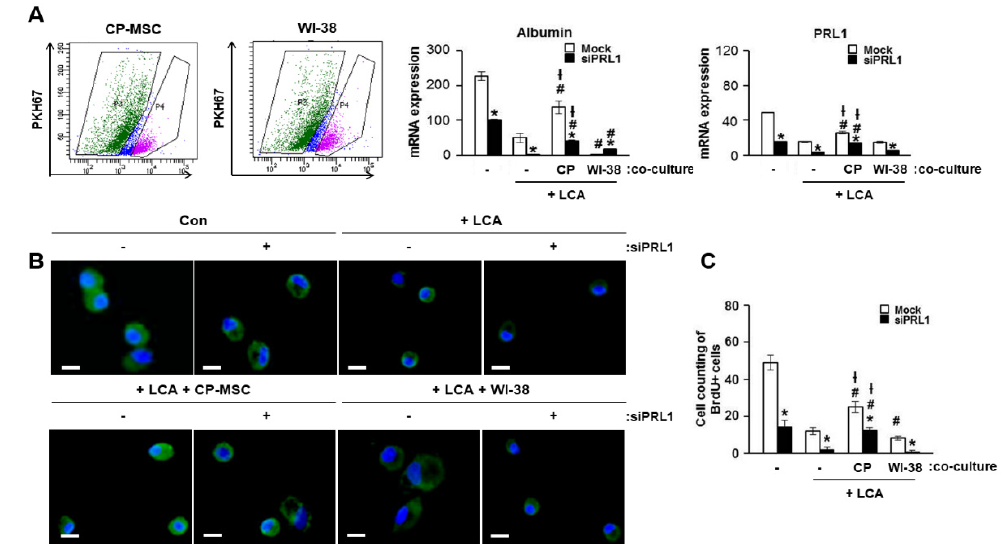
Figure 6. Increased PRL ‐ 1 expression by CP ‐ MSCs correlates with hepatocyte proliferation. ( A ) The fraction of PKH67 ‐ negative primary rat hepatocytes was sorted by flow cytometry in the CP ‐ MSC and WI ‐ 38 direct co ‐ cultured group 24 h after treatment with siRNA ‐ PRL ‐ 1. mRNA expression of albumin and PRL ‐ 1 in sorted primary rat hepatocytes treated with siRNA ‐ PRL ‐ 1 after direct co ‐ culture with CP ‐ MSCs and WI ‐ 38 was examined by qRT ‐ PCR. The localization of ( B ) albumin and ( C ) BrdU ‐ positive hepatocytes was determined with immunofluorescence in rat primary hepatocytes isolated from a BDL rat model treated or untreated with siRNA ‐ PRL ‐ 1 after culturing with or without CP ‐ MSCs or WI ‐ 38 cells. Rat primary hepatocytes expressed green fl uorescent protein and were stained for ALB (green) with 4 ʹ ,6 ‐ diamidino ‐ 2 ‐ phenyl ‐ inodole (DAPI) (blue). A representative overlay image is shown. The scale bar represents 50 μ m. The data are expressed as the mean ± SEM (* p < 0.05 compared with siRNA ‐ PRL ‐ 1treatment group; # p < 0.05 compared with the LCA treatment group; † p < 0.05 compared with the treatment regardless of LCA or siRNA ‐ PRL ‐ 1). CP, CP ‐ MSCs; siPRL1, siRNA ‐ PRL ‐ 1; LCA, lithocholic acid.